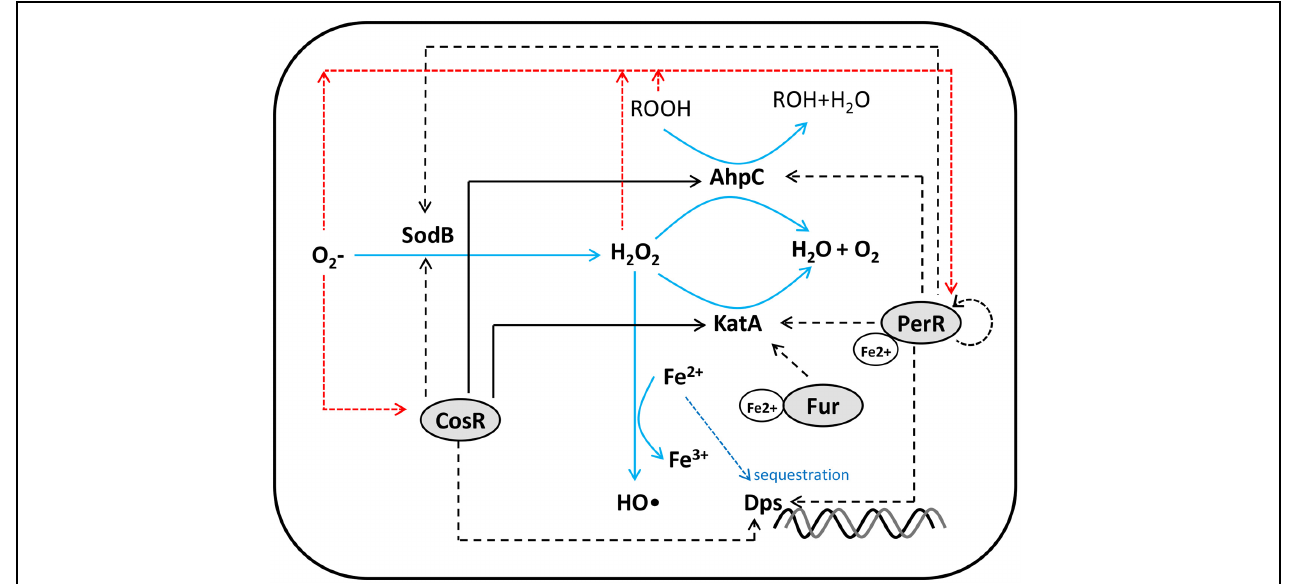
oxidative stress resistance in C. jejuni . Positive and negative regulations are indicated by black solid and dotted lines, respectively. Red dotted lines show transcriptional or translational down regulation by reactive oxygen species